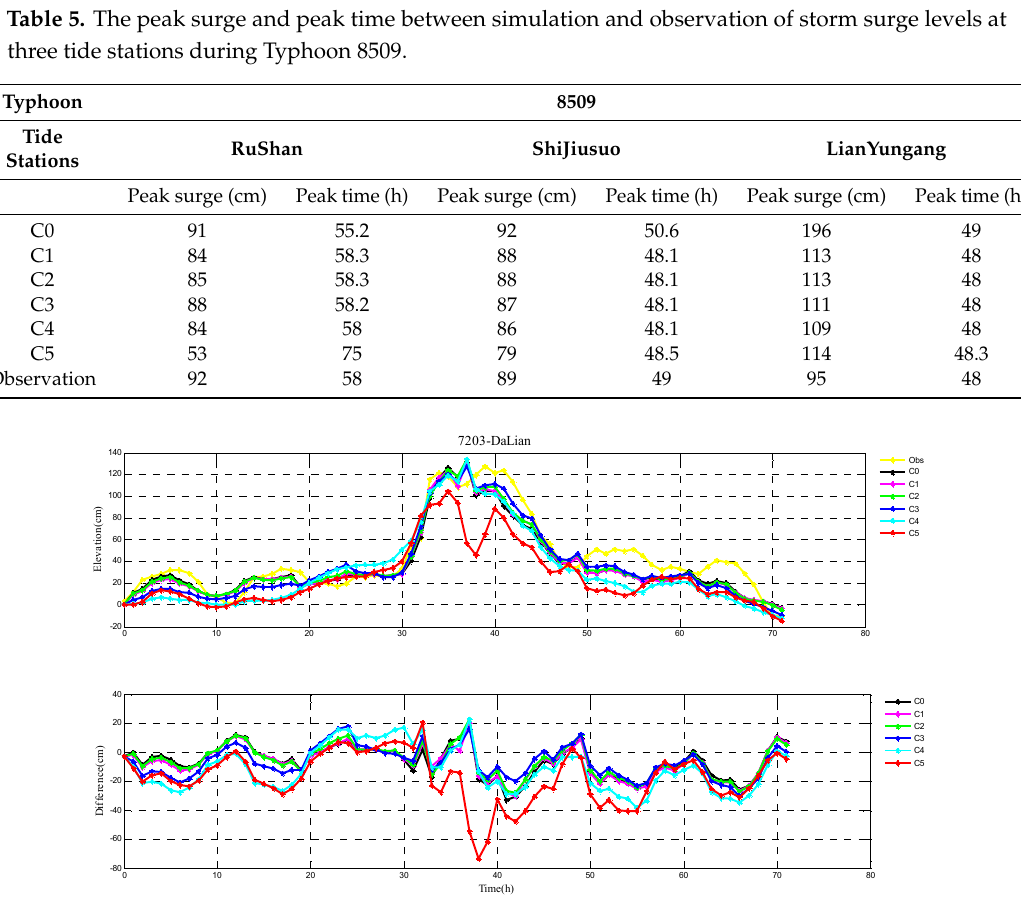
Figure 2. The storm surge elevations (cm) in six cases (C0, C1, C2, C3, C4, C5) and observations (yellow line) (top) and the differences between them (bottom) during Typhoon 7203 at DaLian tide station.